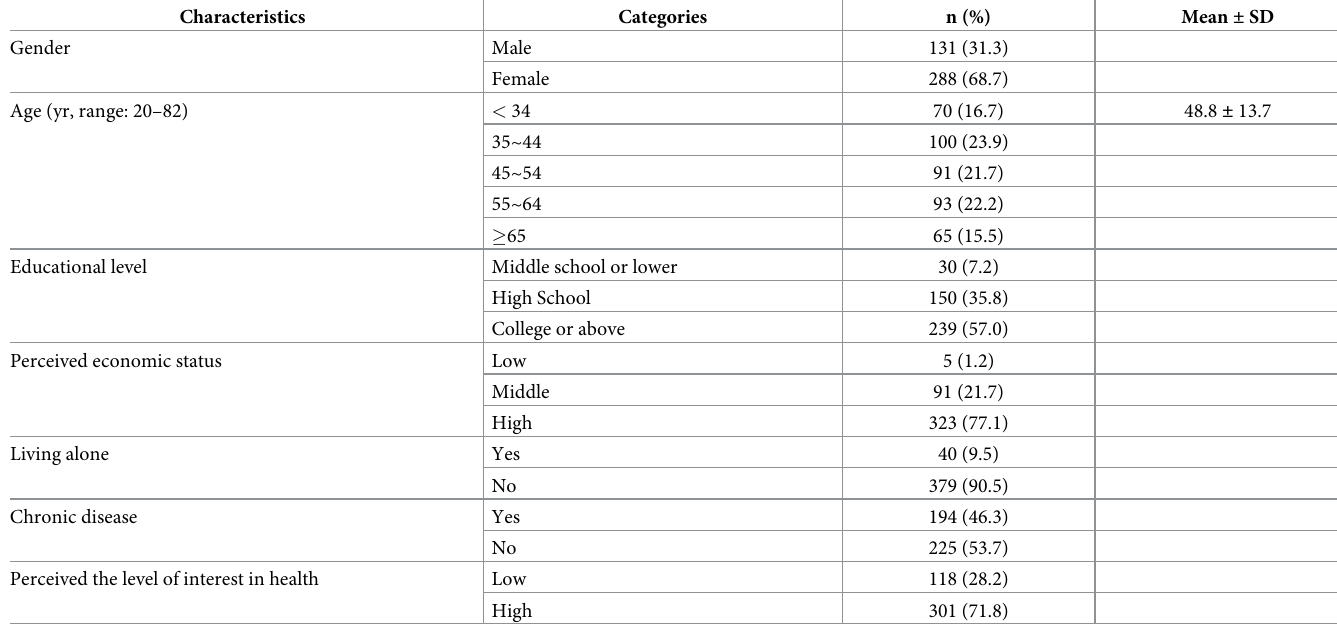
Table 1. Sociodemographic characteristics of Participants (N =